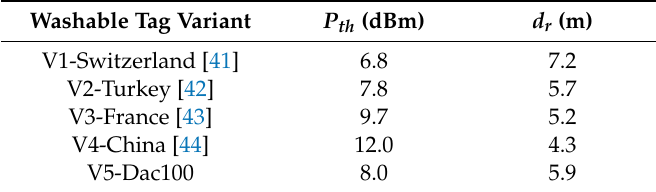
Table 6. The threshold power P th and the read range d r at 900 MHz for tested UHF RFID tag variants. Washable Tag Variant P th